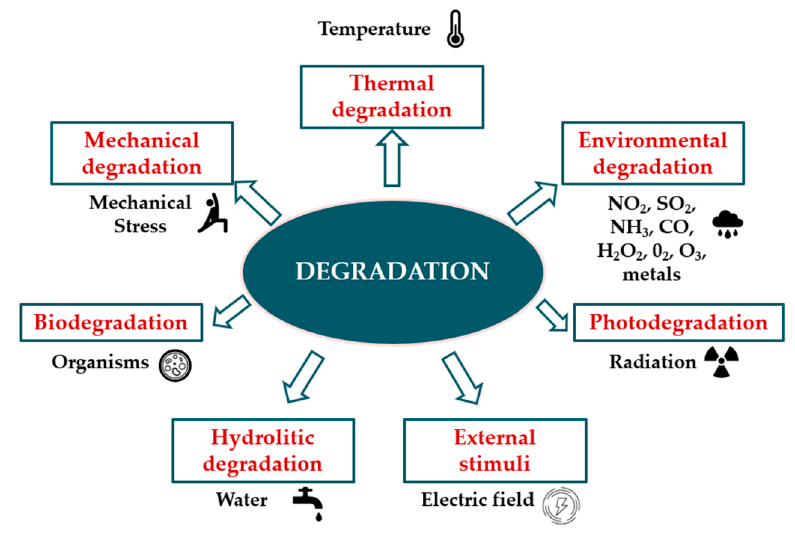
Figure 2. Chemical, physical and biological agents causing various types of degradation.